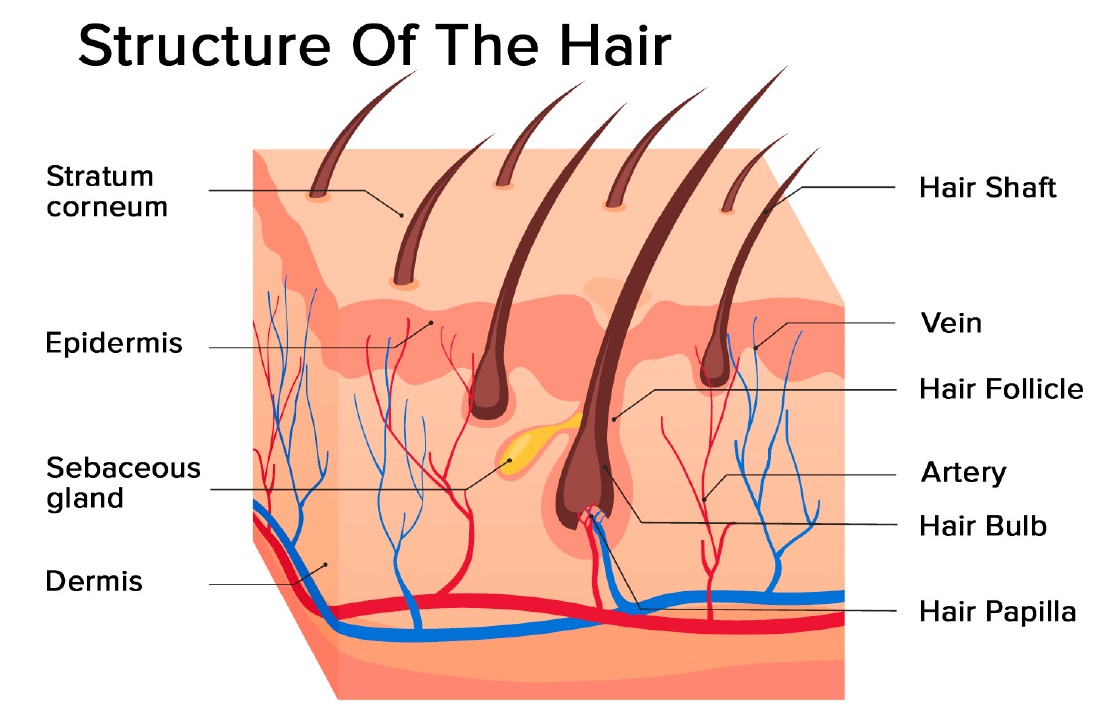
Figure 1. Structure of the hair: hair follicle and hair shaft (modified photo from Freepik).